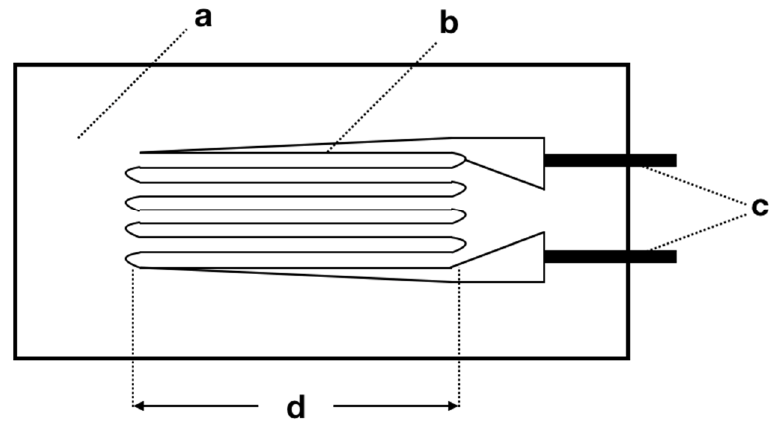
Figure 9. Representation of the variable resistance strain gauge unit. ( a ) support material; ( b ) measuring grid; ( c ) leads; ( d ) effective grid length.